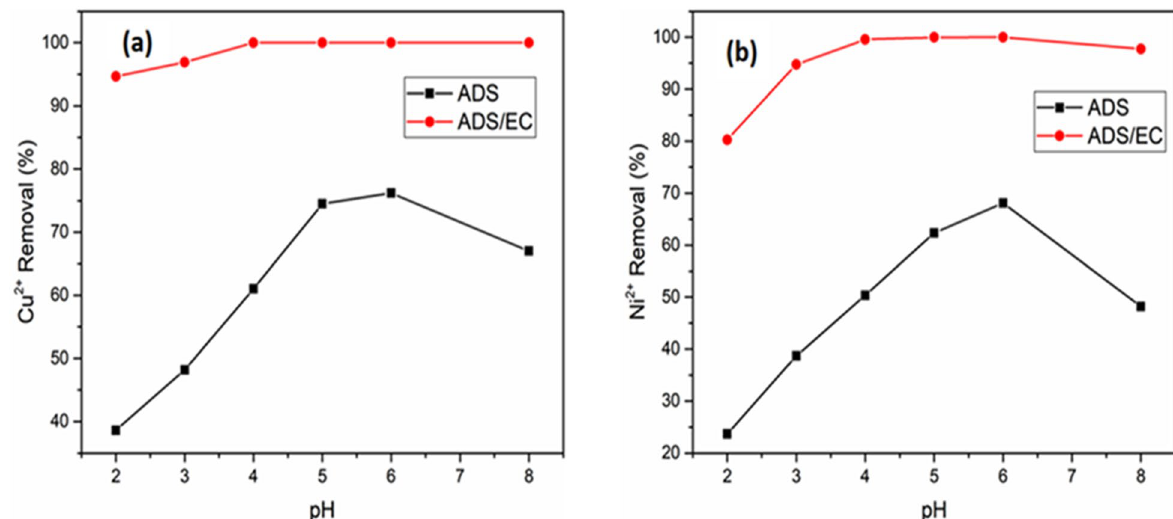
Figure 4. Effect of pH on ( a ) Cu 2+ and ( b ) Ni 2+ removal of the synthesized wastewater during the ADS and ADS/EC coupling processes (AGWTR dose = 1 g L −1 , Initial conc. = 20 mg L −1 and Current density = 1.19 mA cm −2